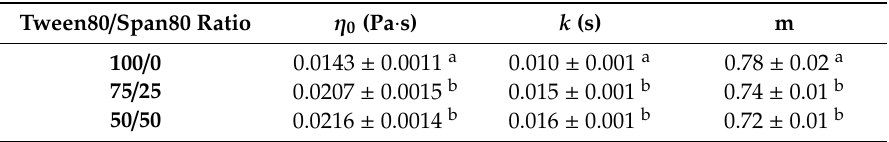
Figure 3. Influence of Tween80 / Span80 ratio on flow behavior for ecological mandarin emulsions. Table 3. Cross model fitting parameters of ecological mandarin emulsions as a function of Tween80 / Span80 ratio. Zero-shear viscosity ( η 0 ), the inverse of critical shear rate ( k ), and m that is related to the flow index. a–c mean value ± standard deviation; values without common superscripts within the same column were significantly different ( p < 0.05).